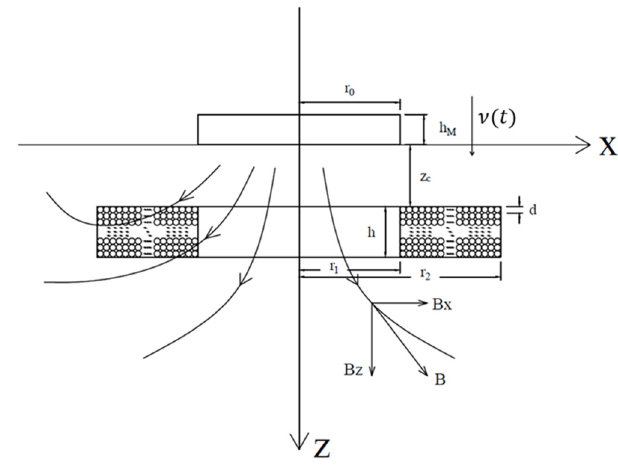
Figure 2. Schematic diagram of magnetic field and coil.